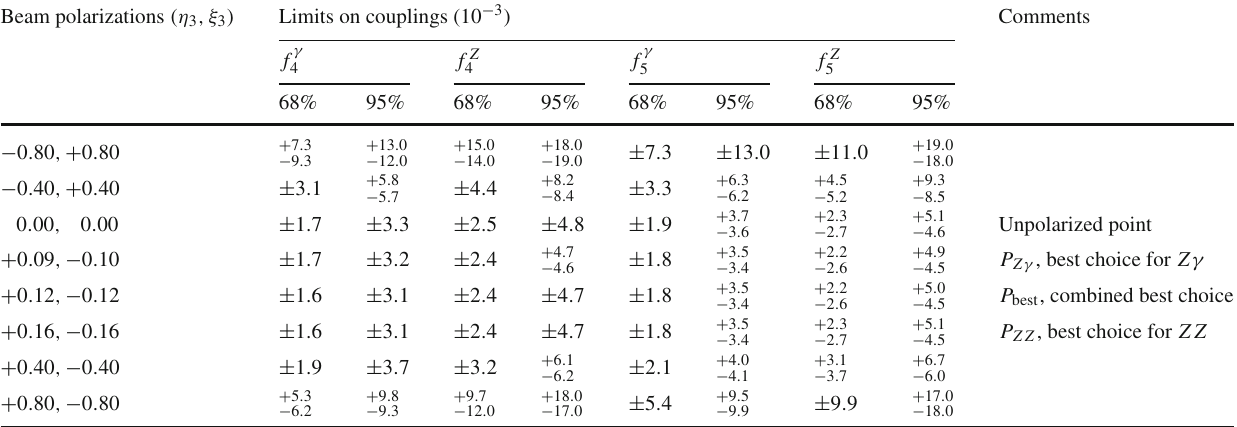
Table 1 List of simultaneous limits on anomalous couplings obtained for in Z Z process Beam polarizations (η 3 ,ξ 3